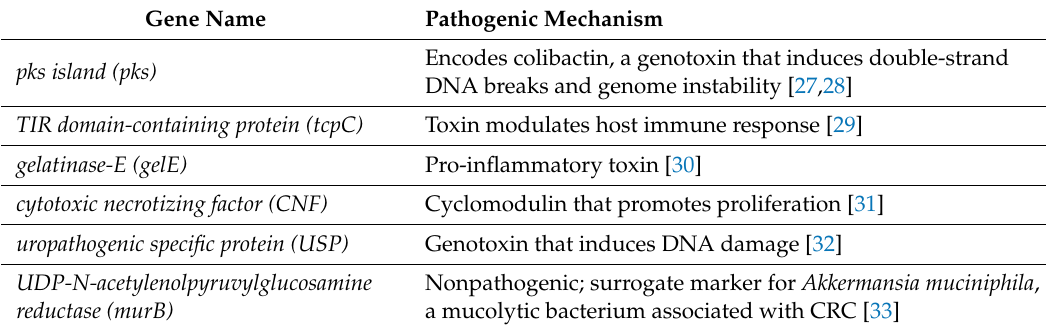
Table 1. A list of six bacterial genes in this study and their known pathogenic